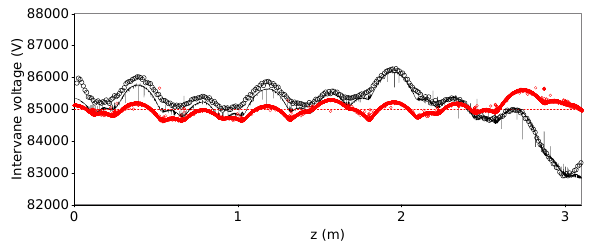
Figure 15. An optimized voltage profile (in red) as compared to the original one without optimization (black).